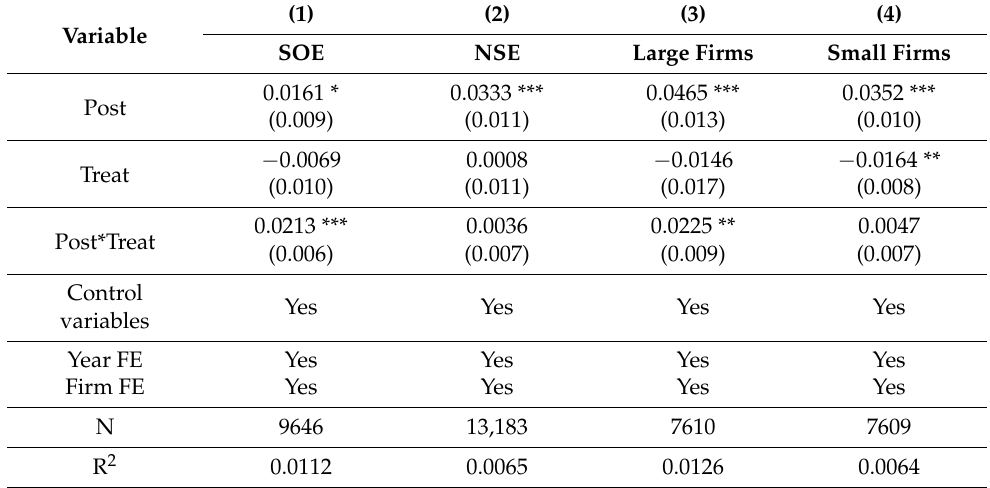
Table 8. Heterogeneous impact of green credit guidelines on green innovation: sub-sample regression.